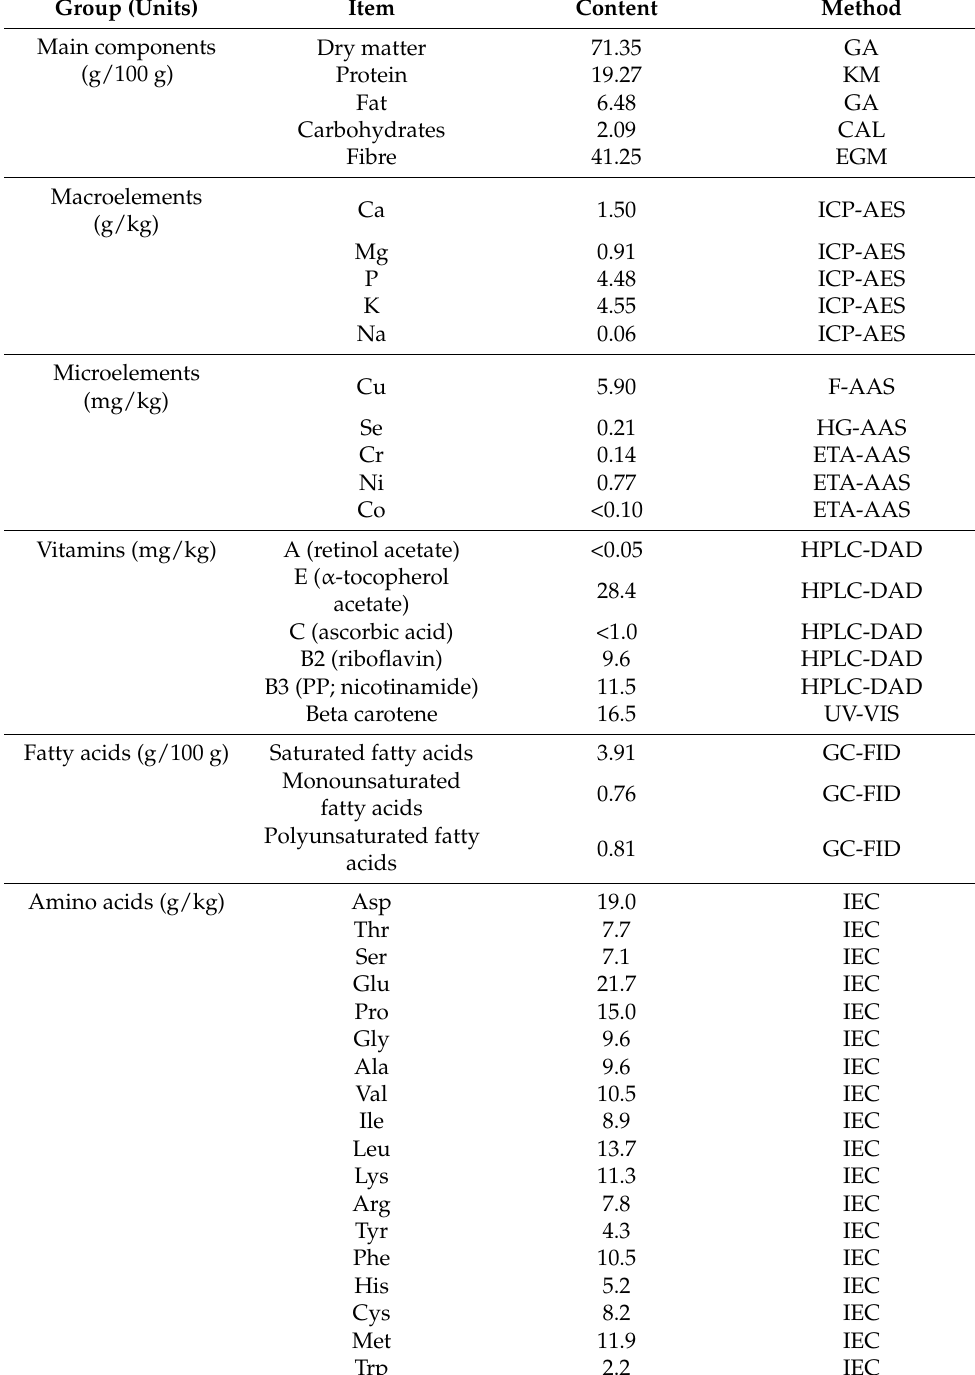
Table 1. Chemical composition of BB used in the